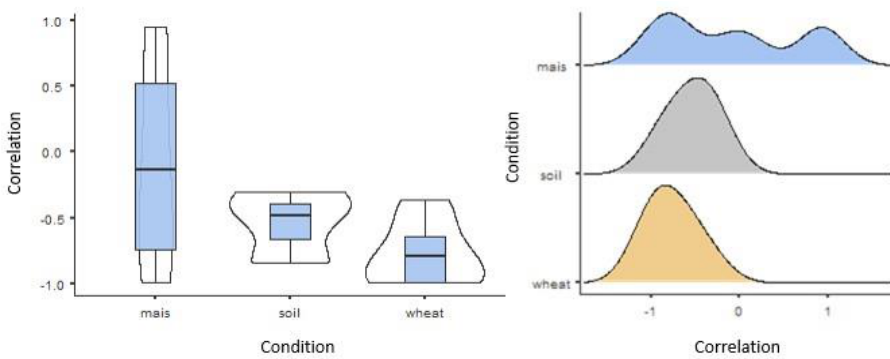
Figure 7. Distribution of the correlation values between maps produced with sensors and with the geoelectric method.